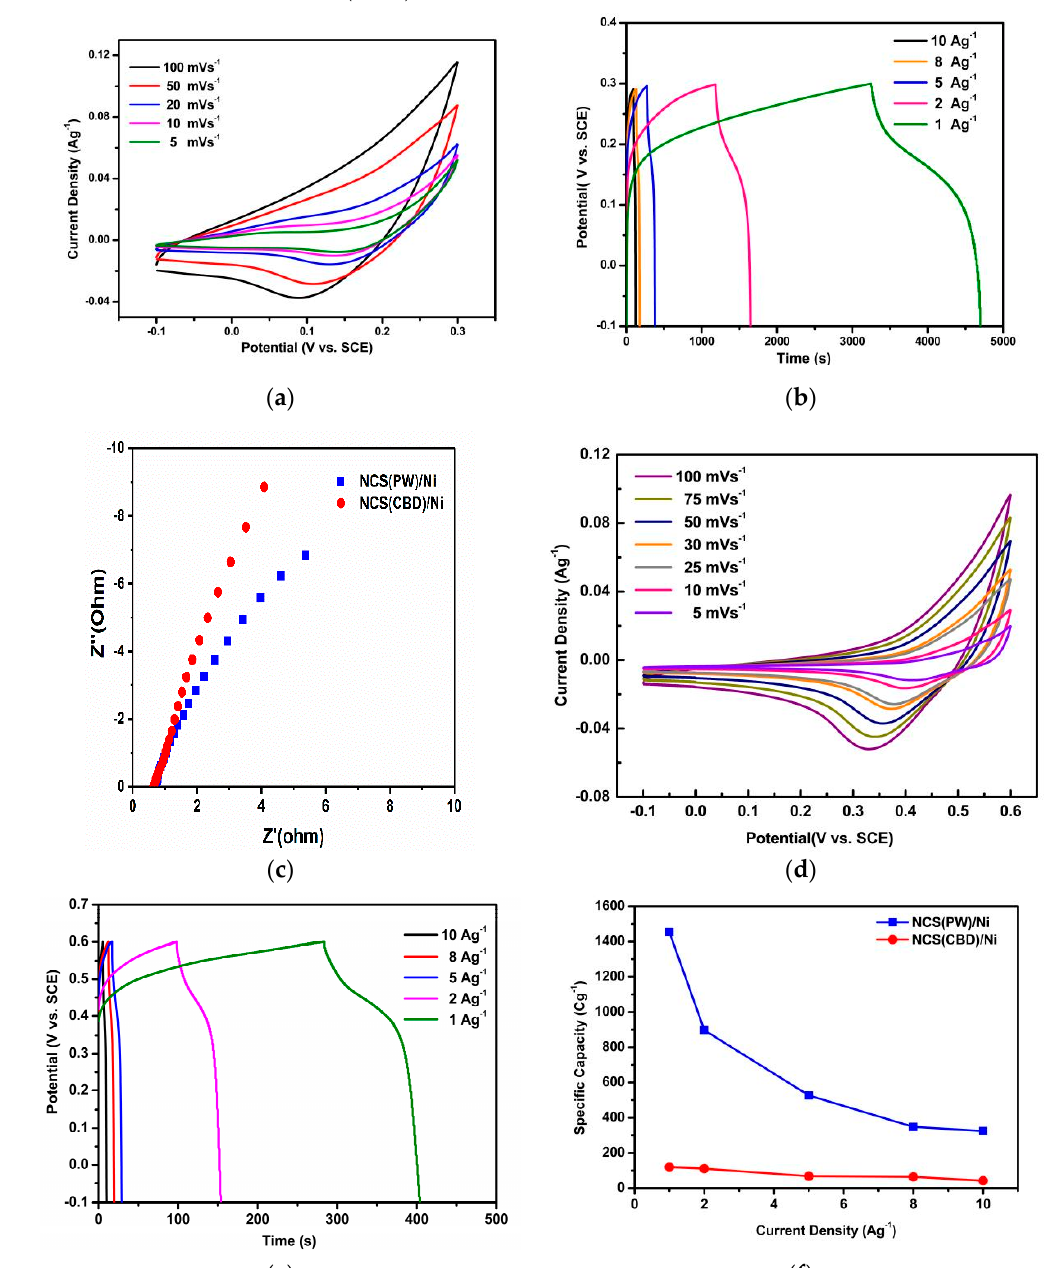
Figure 4. Electrochemical properties of NiCo 2 S 4 materials: ( a ) the CV curves of NiCo 2 S 4 electrodes synthesized by the hydrothermal method (NCS(PW)/Ni electrodes); ( b ) charging and discharging analysis by chronopotentiometry (CP) measurements for NCS(PW)/Ni electrodes; ( c ) the EIS spectra of both NCS(PW)/Ni and NCS(CBD)/Ni electrodes; ( d ) the CV curves of NCS(CBD)/Ni electrodes, ( e ) CP measurements of NCS(CBD)/Ni electrodes, ( f ) a comparison of the specific capacities of both NCS(PW)/Ni and NCS(CBD)/Ni electrodes.